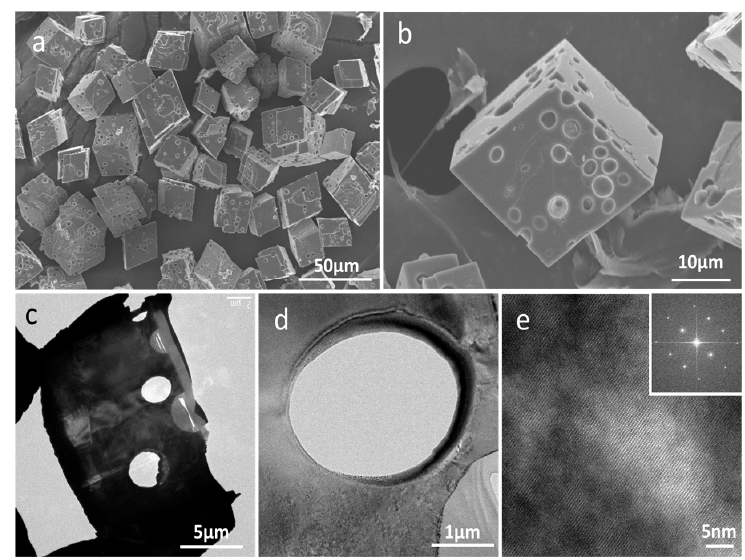
Figure 4. ( a , b ) SEM images of cell-embedded CaCO 3 crystals; ( c , d ) TEM images of cell-embedded CaCO 3 crystals after thin sectioning by focused ion beam (FIB); ( e ) HR-TEM image of ( d ) and (inset) the selected area electron diffraction (SAED) pattern.